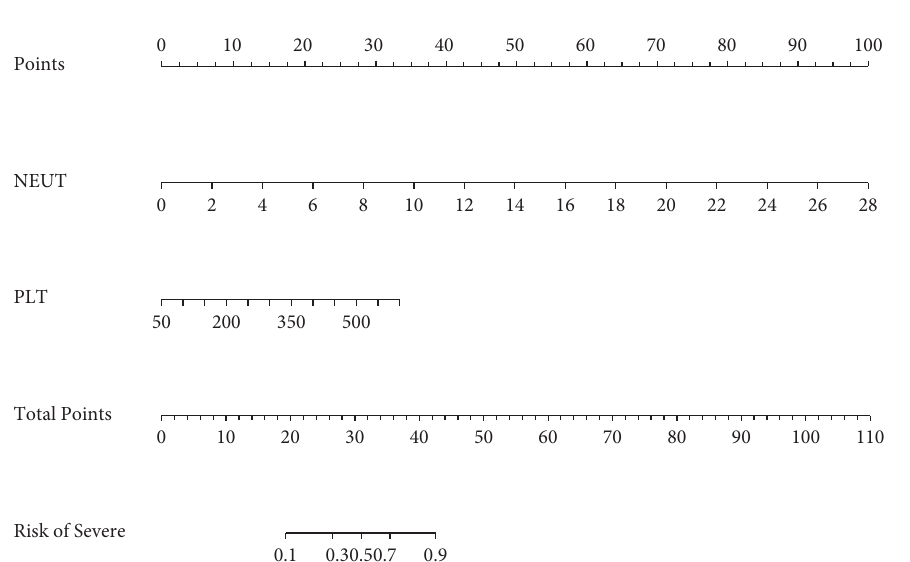
Figure 6: Nomogram model based on independent predictive factors for COPD severity.